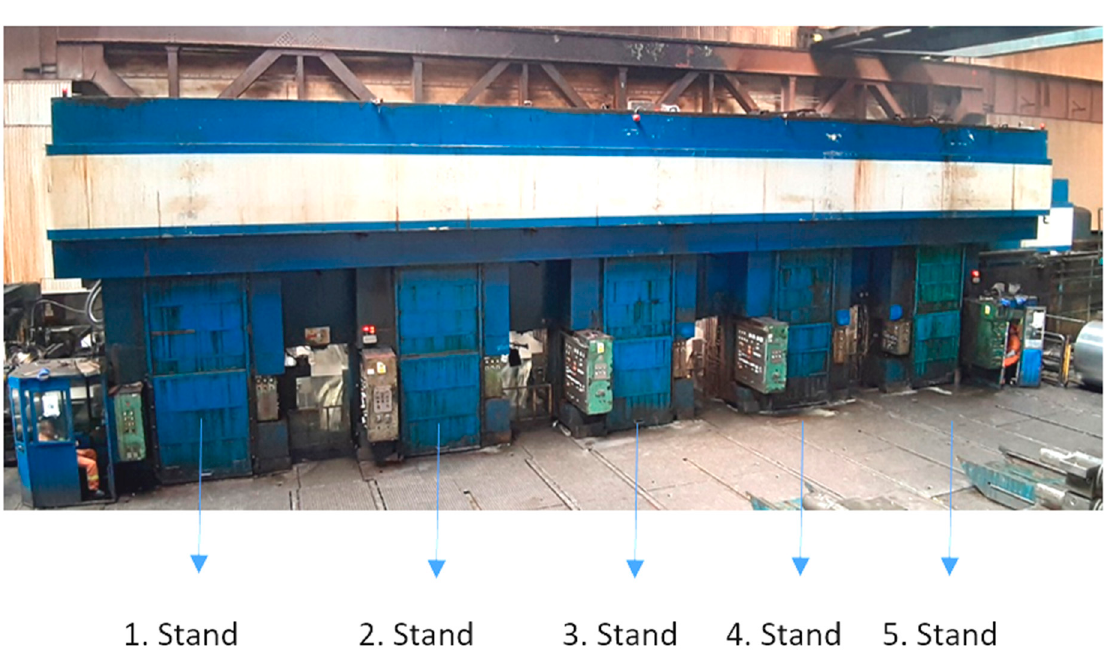
Figure 1. Five-stand cold-rolling tandem mill.